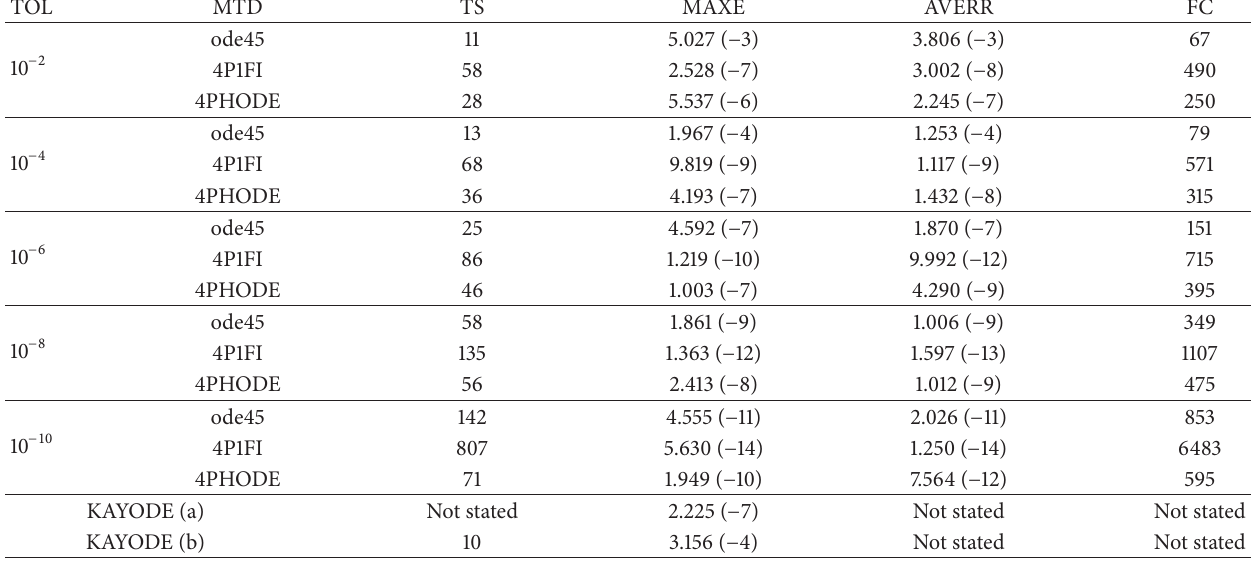
Table 2: Numerical results for solving Problem